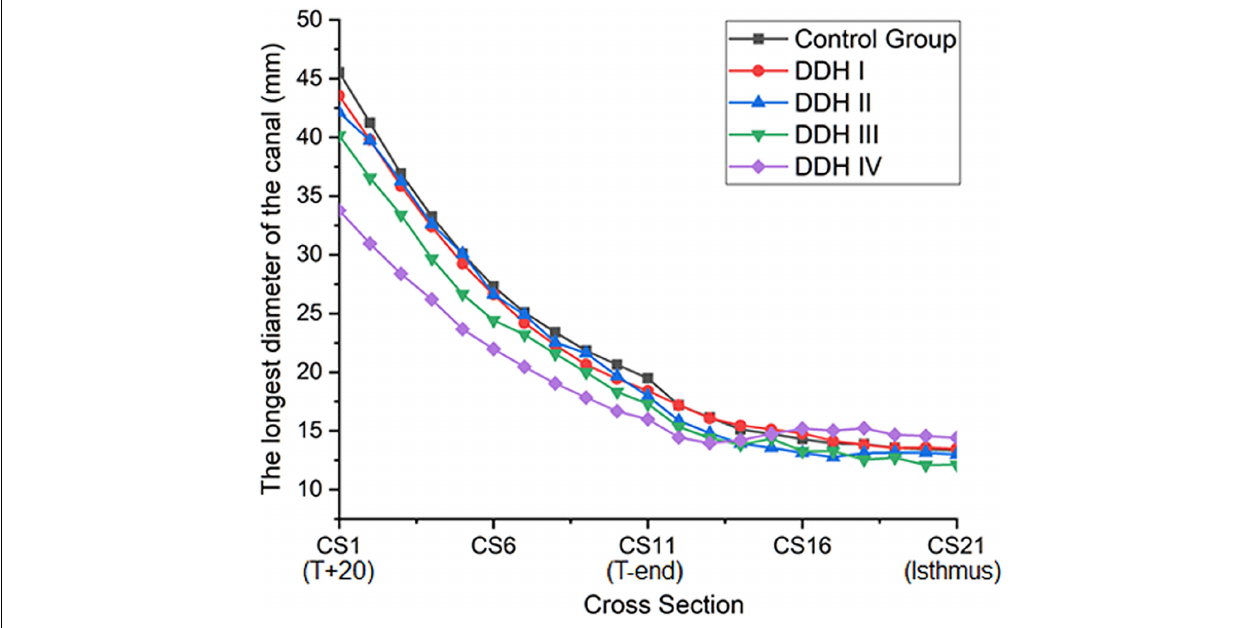
FIGURE 2 | A plot showing the longest diameter of the femoral canal for all subjects. TABLE 2 | The longest diameter in all subject groups.